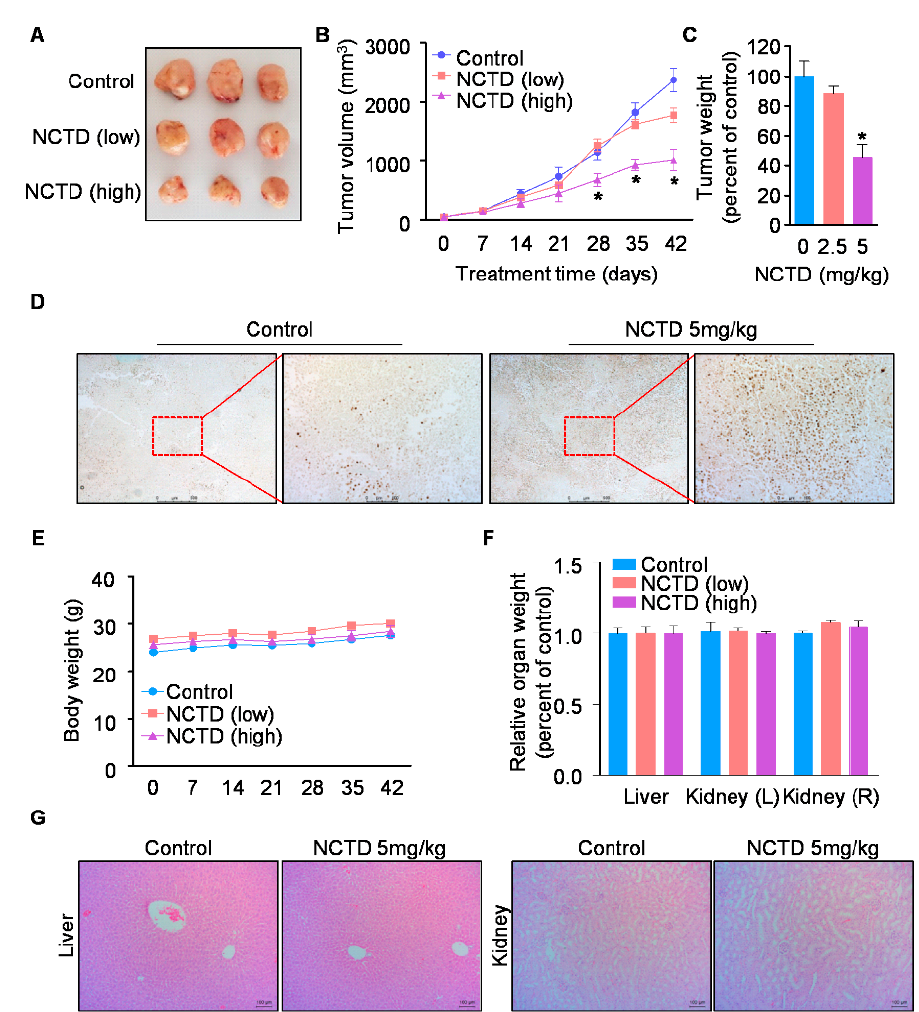
Figure 5. Effects of NCTD on tumor growth in a nude mouse xenograft model bearing HSC-3 cells. Athymic nude mice bearing HSC-3 cells were treated with vehicle control or NCTD (2.5 or 5 mg/kg) for 42 days ( n = 4/group). ( A ) Representative images of tumors of mice after mice sacrificed. Tumor volume ( B ) and tumor weight ( C ) were measured. The graphs represent the mean ± S.E. of triplicate experiments. *, p < 0.05 is compared with control group. ( D ) Programmed cell death was detected in tumor tissues using a Terminal Deoxynucleotidyl Transferase dUTP Nick end Labeling (TUNEL) assay (original magnification, × 50). The red boxes represented cropped fields at × 200 magnification. Body weight ( E ) or organ weights ( F ) were measured. ( G ) Organ tissue samples (left panel: liver; right panel: kidney) were subjected to histopathological analysis using hematoxylin and eosin (H&E) staining (original magnification, ×100).